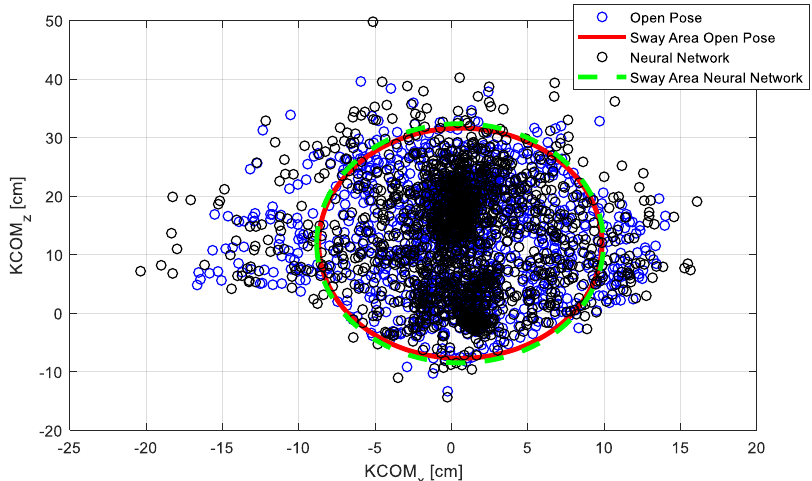
Figure 10. Comparison between estimated and acquired key points in different body configurations.